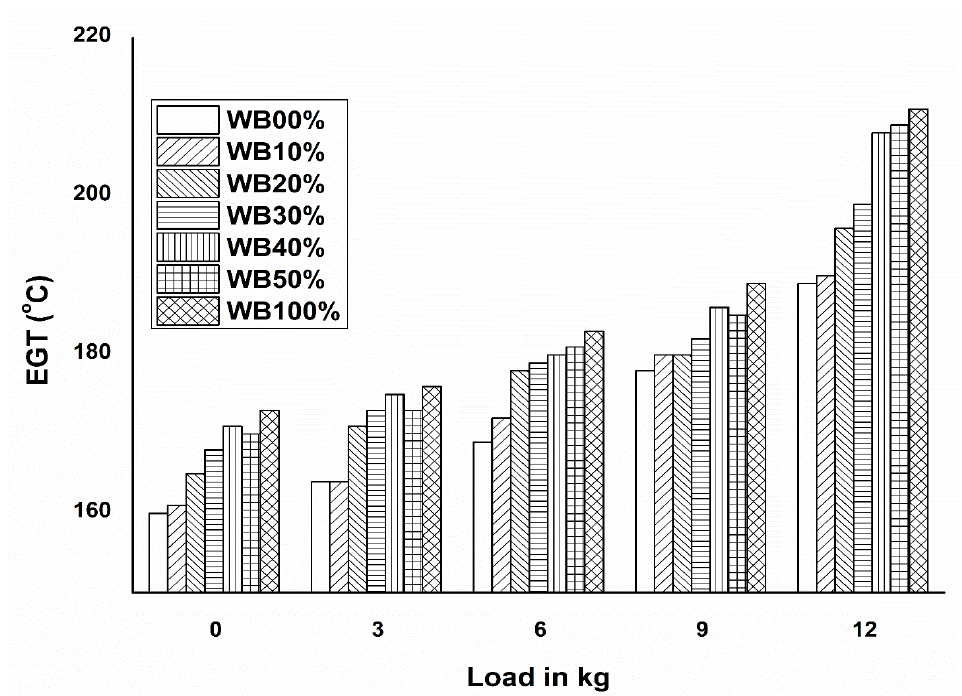
Figure 6. EGT variation against load for biodiesel and the blends in kg (WB00%—diesel fuel; WB10%—biodiesel 10% + diesel 90%; WB20%—biodiesel 20% + diesel 80%; WB30%—biodiesel 30% + diesel 70%; WB40%—biodiesel 40% + diesel 60%; WB50%—biodiesel 50% + diesel 50%; WB100%—pure biodiesel).